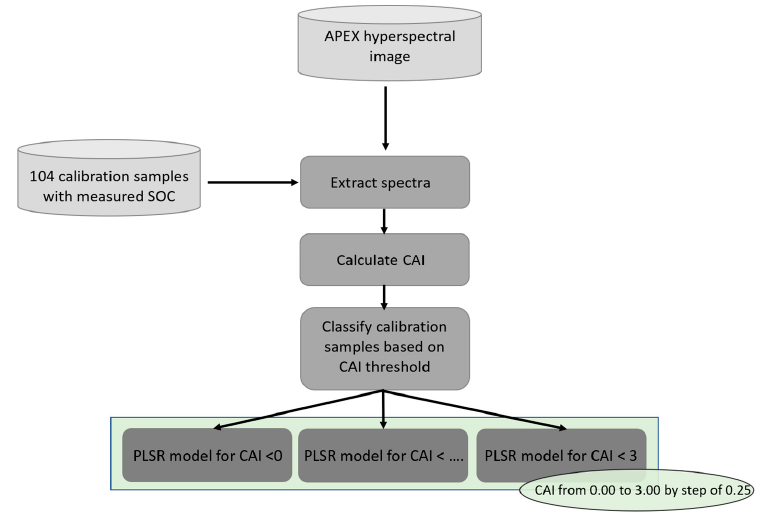
Figure 4. Overview of the soil organic carbon (SOC) prediction approach.